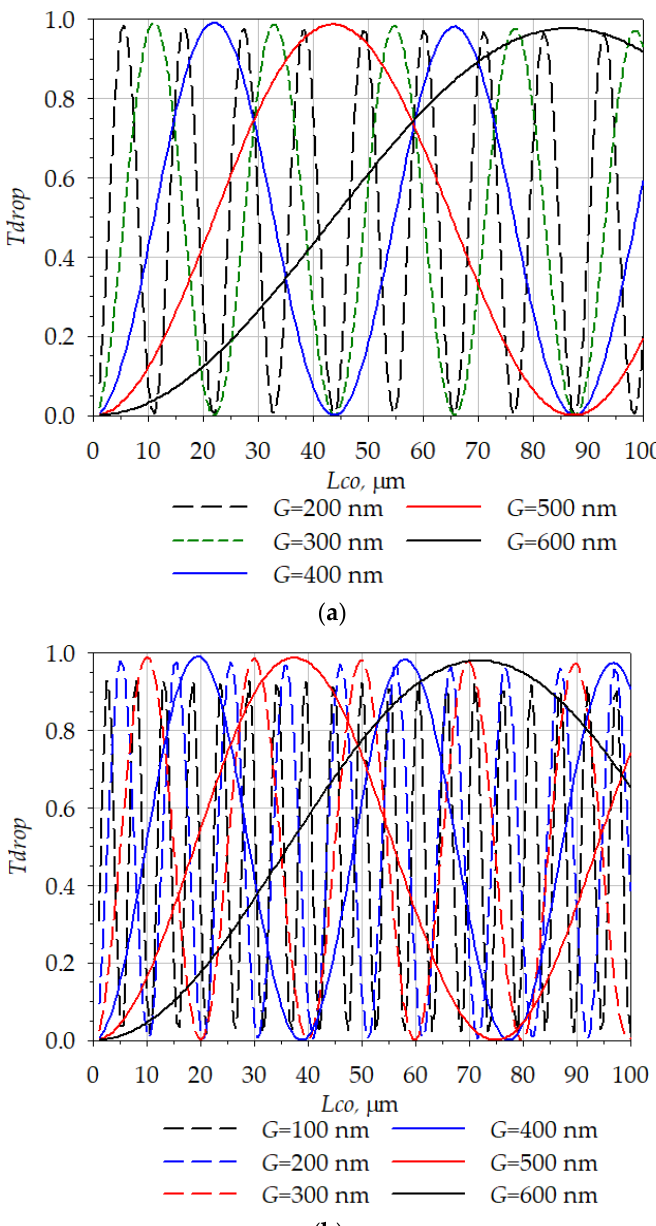
Figure 10. Dependence of the optical transmission coefficient on the inertial mass displacement along axis X for the OMT with single-plane waveguides (Scheme 2). ( a ) Waveguides with dimen- sions of 300 × 1000 nm; ( b ) Waveguides with dimensions of 300 × 750 nm. The same analysis was performed for Functional Scheme 8 (Figure 5b) with different- plane waveguides (Figures 11 and 12).